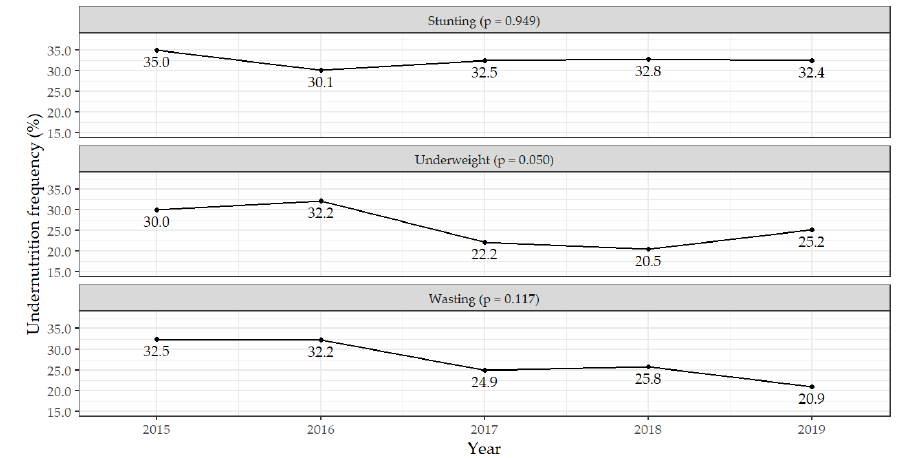
Figure 2. Frequency of undernutrition type in children by year of admission.